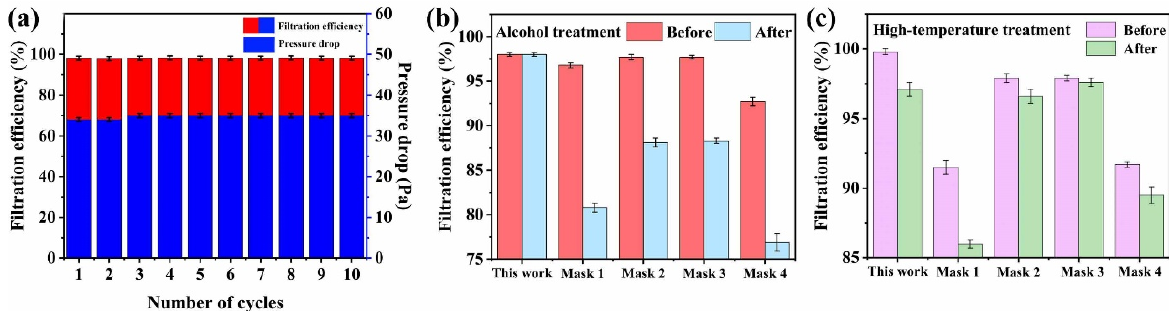
Figure 7. ( a ) Cycle test performance of the CA/TPU ‐ 1LiCl fiber membrane; ( b ) Effect of alcohol disinfection on filtration performance; ( c ) Effect of heating disinfection on filtration performance.